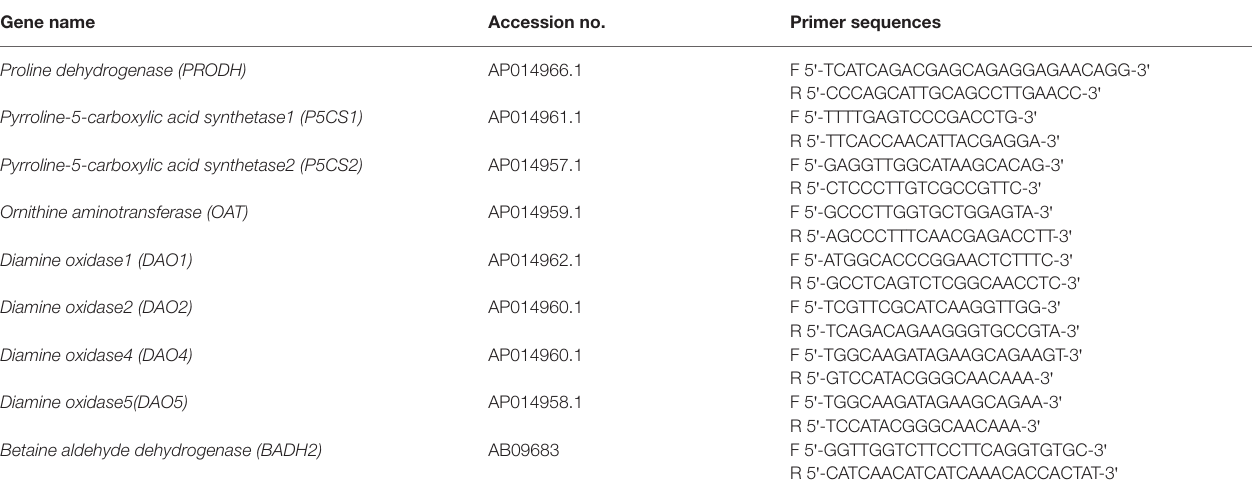
TABLE 1 | Primer sequences of genes encoding enzymes involved in 2-AP